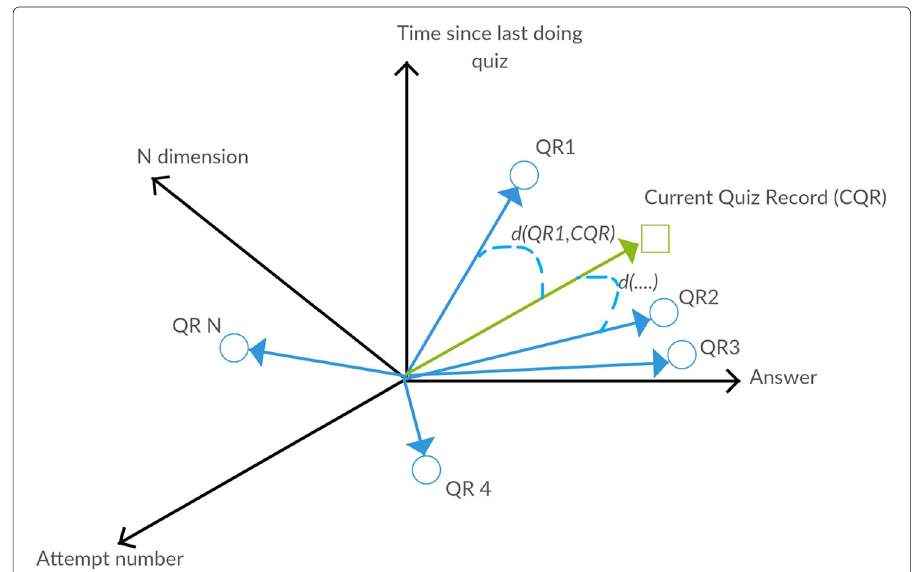
Fig. 2 Representation of quiz records in